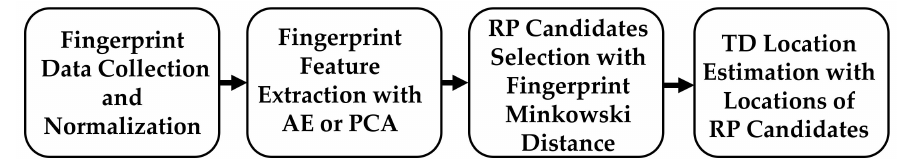
Figure 1. The major steps of the proposed FPFE localization